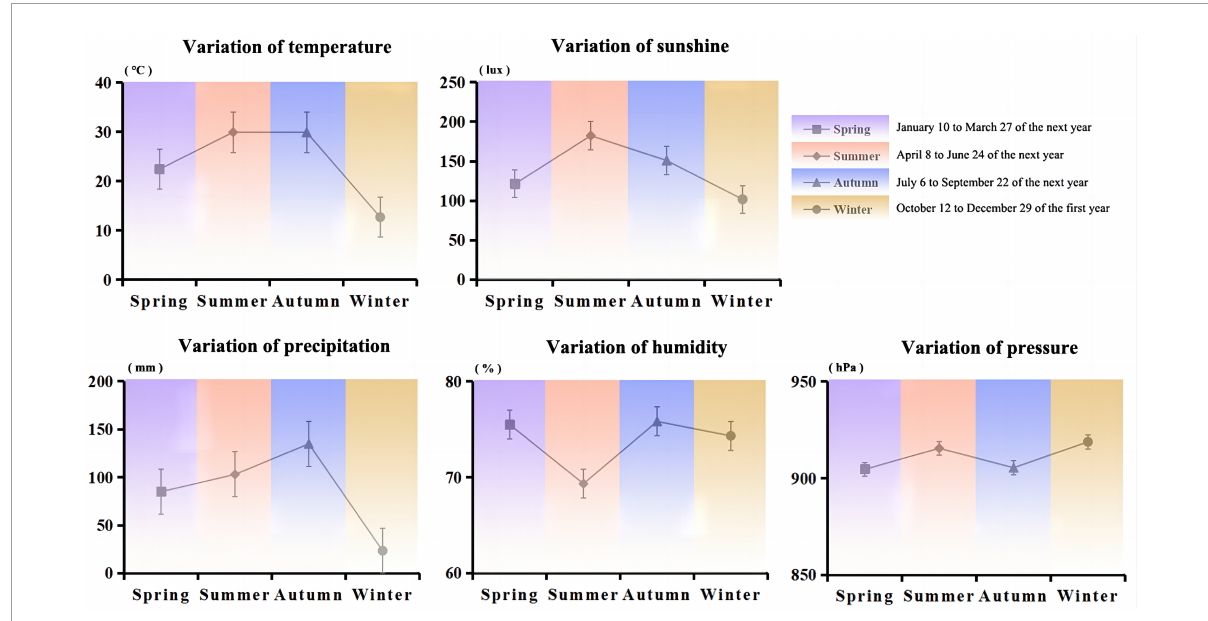
FIGURE1 Variations in the average values of five climatic factors (temperature, sunshine, precipitation, humidity, and pressure) for different seasons in Moutai Town, Guizhou Province.